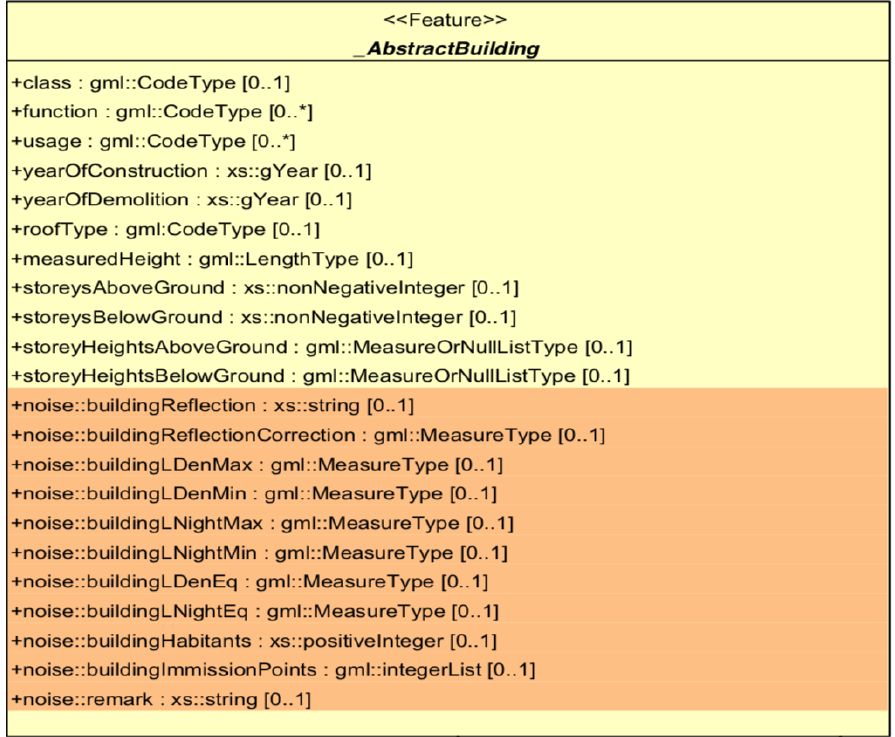
Figure 2. Original attributes in the the UML model of the CityGML _AbstractBuilding (shown in yellow) and extended attributes in the Noise ADE (shown in orange) (Source: CityGML 2.0.0 Specifications [10]).